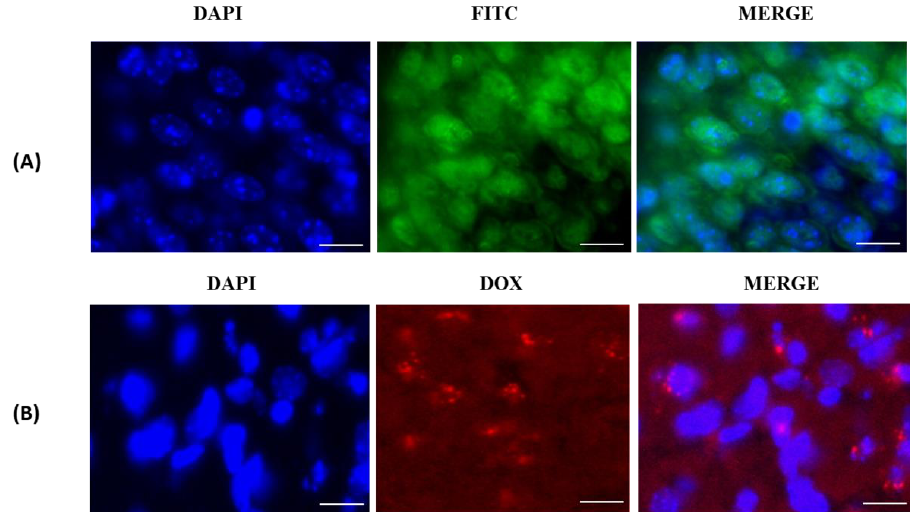
Figure 5. ( A ) Fluorescence microscopic images of CuMSN (100 µg/mL) cellular uptake with the treatment of FITC-labeled CuMSN (100 µg/mL), and ( B ) intracellular DOX uptake in A549 cells treated with CuMSN@DOX@PDA (20 × magnification) (scale bar 100 µm).